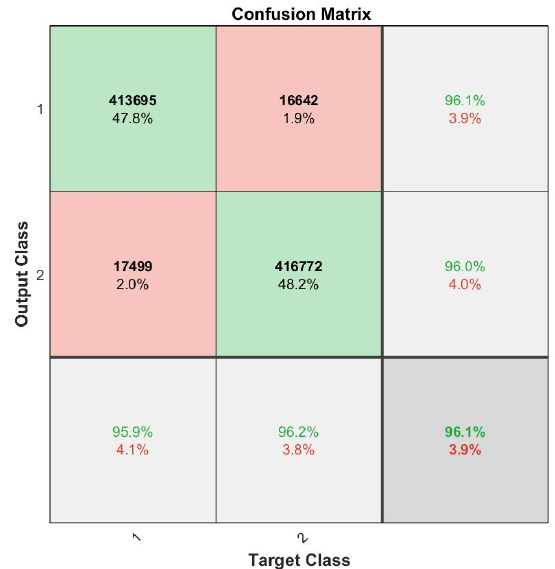
Figure 14. MWR SIE Antarctic confusion matrix.